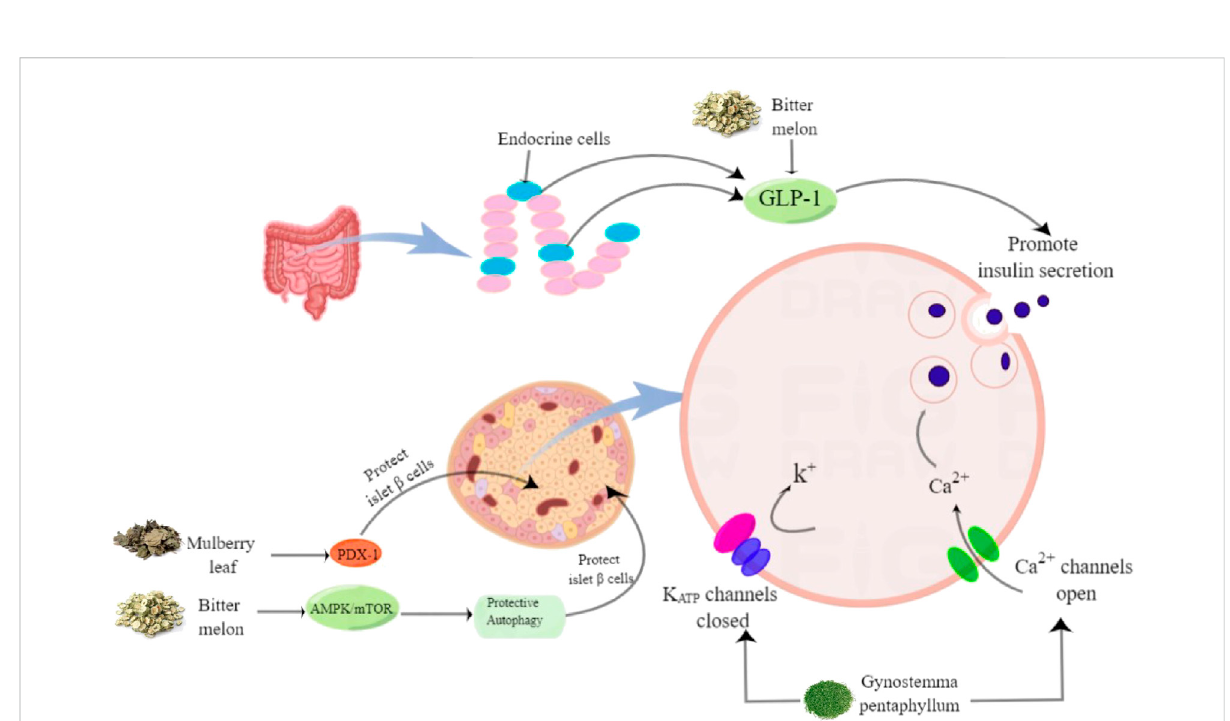
FIGURE 2 The effects of herbal teas in protecting islet beta cells and promoting insulin